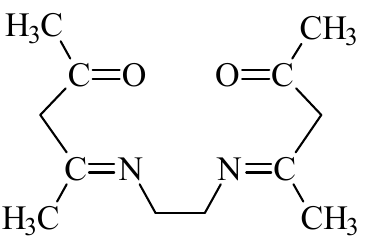
Figure 2. Structure of ethylenodiamino ‐ bis ‐ acetylacetone (EDAB ‐ acac).